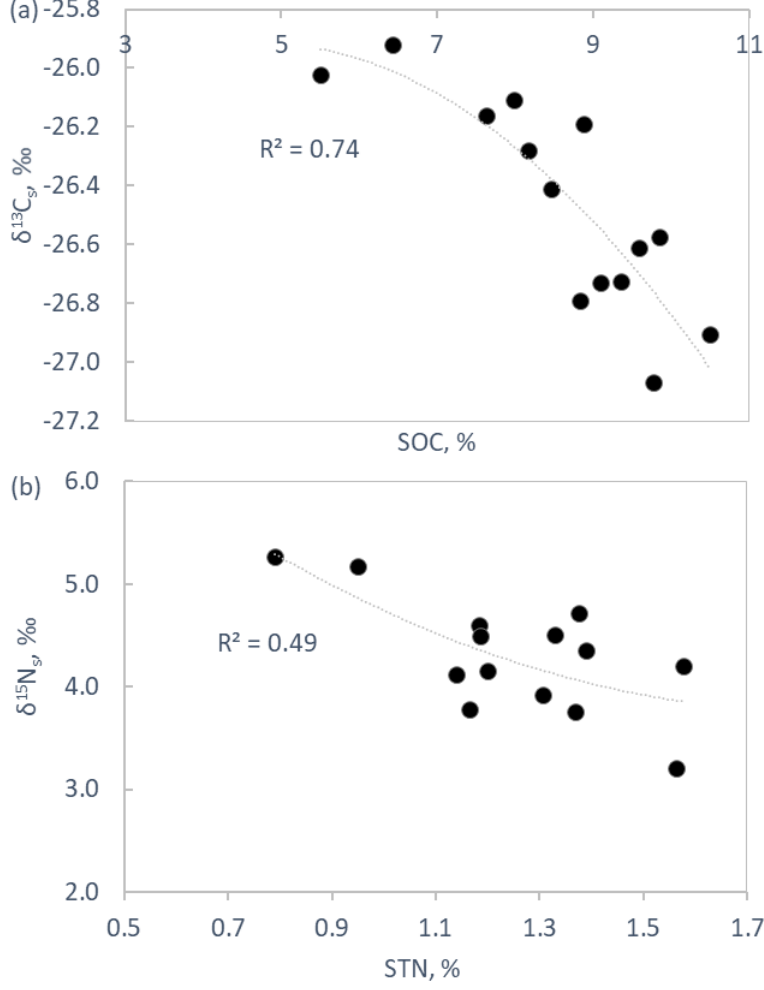
Figure 4. ( a ) Soil δ 13 C ( δ 13 C s ) plotted versus soil organic C concentration (SOC); ( b ) soil δ 15 N ( δ 15 N s ) plotted versus total soil N concentration (STN).